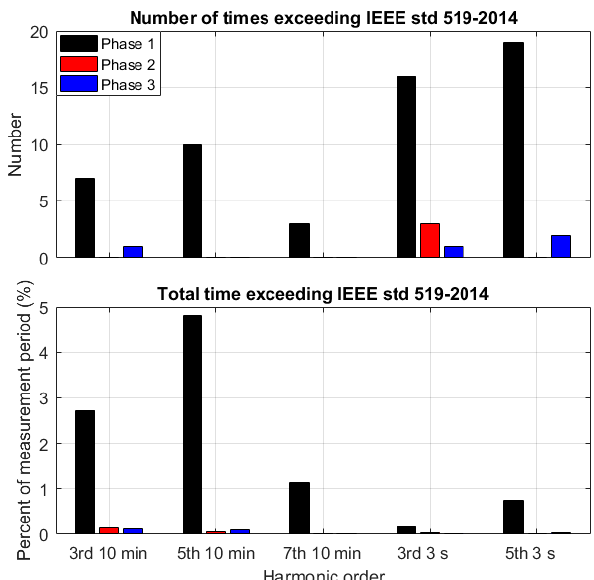
Figure 24. The number of times the individual harmonics exceeded the 10 min (in weeks) and 3 s limit (in days) in IEEE 519-2014 ( top ) and the amount of time during the measurement period of 48 weeks in which the individual harmonics exceeded the limits in IEEE 519-2014 ( bottom ) for islanded operation.